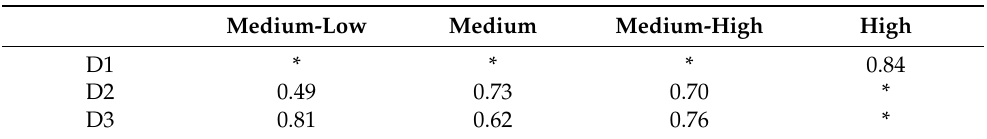
Figure 12. The percentage of different equivalent heat island intensities (EHII) in terms of the area. Table 4. Correlation between the equivalent heat island intensity (EHII) and central heating supply. (* indicates the value that fails the P check).